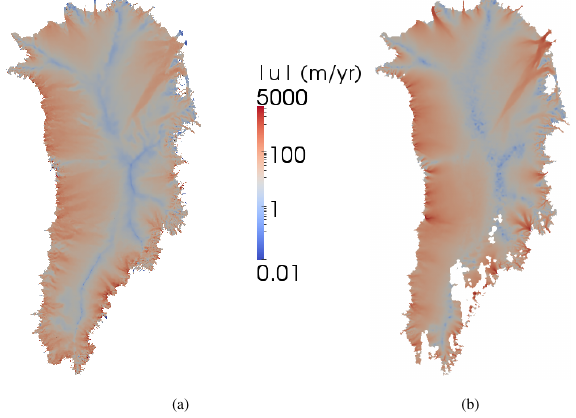
Figure 15. Solution magnitude | u | in meters per year: (a) Al- bany/FELIX solution (surface speed) on the variable resolution (1– 7km) tetrahedral mesh, and (b) observed surface speeds (from Joughin et al. (2010)).